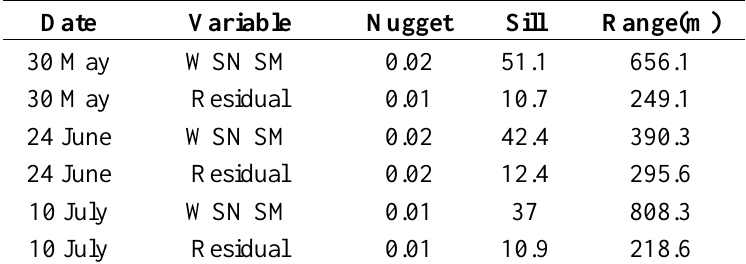
Table 3. Parameters of the variogram models.